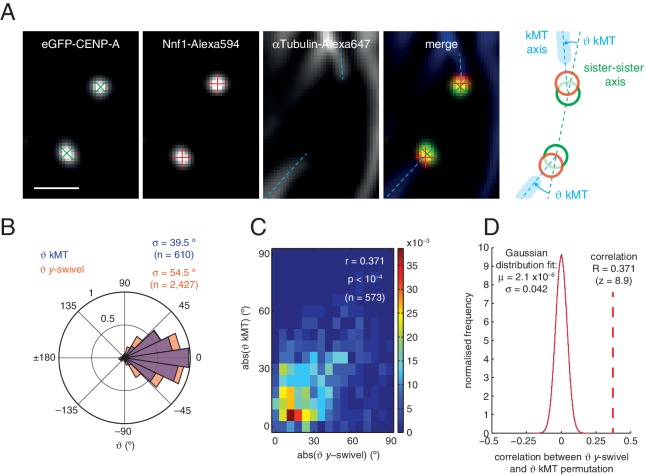
Inner and outer kinetochore markers are generally co-linear with their attached k-fibre.(A) Kinetochores exhibiting swivel marked by eGFP-CENP-A, Nnf1-Alexa594 and αTubulin-Alexa647. Green and red crosses represent the centre of eGFP and Alexa594 spots, respectively; dashed blue lines represent kinetochore-microtubule (kMT) axes determined from k-fibre fluorescence close to the kinetochore. Scale bars 200 nm. The schematic demonstrates the measurement of the angle tended by the kMTs on the sister-sister axis, ϑ kMT. (B) Distributions of ϑy-swivel (gold; n = 2427) and ϑ kMT (blue; n = 610) in cells expressing eGFP-CENP-A and Nnf1-Alexa594. (C) 2D histogram of absolute ϑ kMT versus absolute ϑ y-swivel, which are significantly correlated (r = 0.371, p < 10–4, n = 573; see supplementary material), demonstrating that kMTs are generally aligned along the intra-kinetochore axis. (D) Permutation test of significance of correlation between absolute ϑy-swivel and absolute ϑ kMT (blue), and the best fit Gaussian distribution to the data (red; µ = 2.1 × 10–6, σ = 0.042), with Monte Carlo sampling of 106 permutations. Red dashed line is the observed correlation between ϑy-swivel and ϑ kMT, which demonstrates the significance of correlation (p = 2.8 × 10–19, z = 8.9).